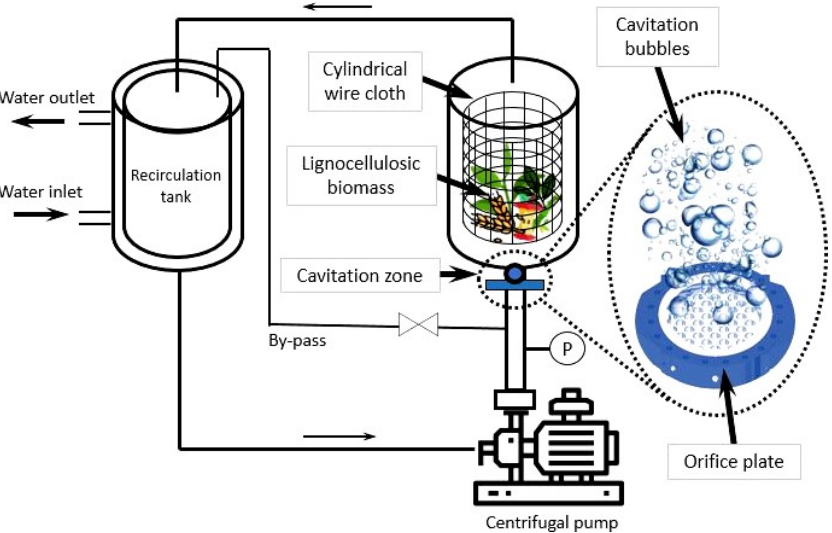
Figure 13. Schematic representation of HC system used for SCB pretreatment.